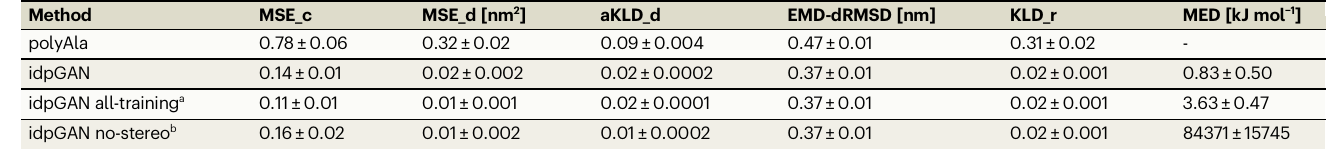
Table 2 | Evaluation of idpGAN for the HB_val set